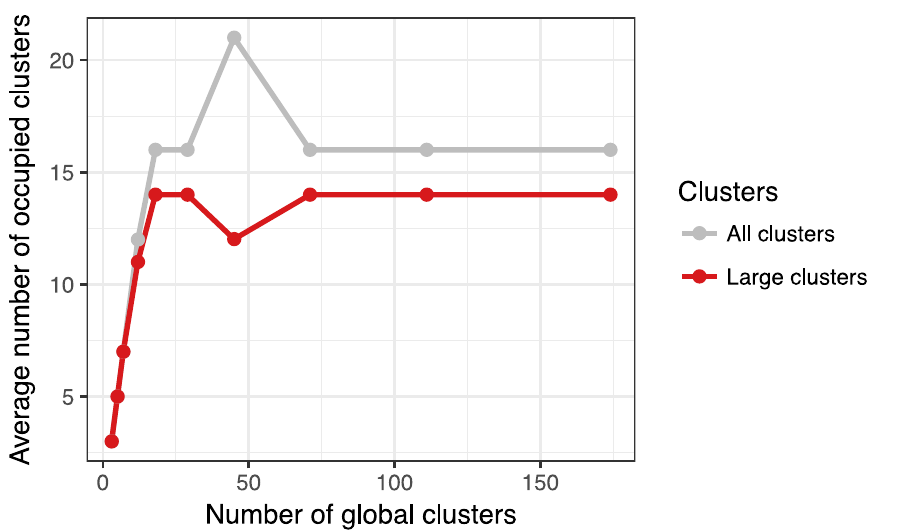
Fig 12. Average number of occupied clusters across different numbers of global clusters. The number of clusters is the averageof the posterior number of globalclusters that have any samples assignedto them across the MCMC iterations. The figure shows both the total number of occupiedclusters and the numberof clusters that have more than 5 samples assignedto them.